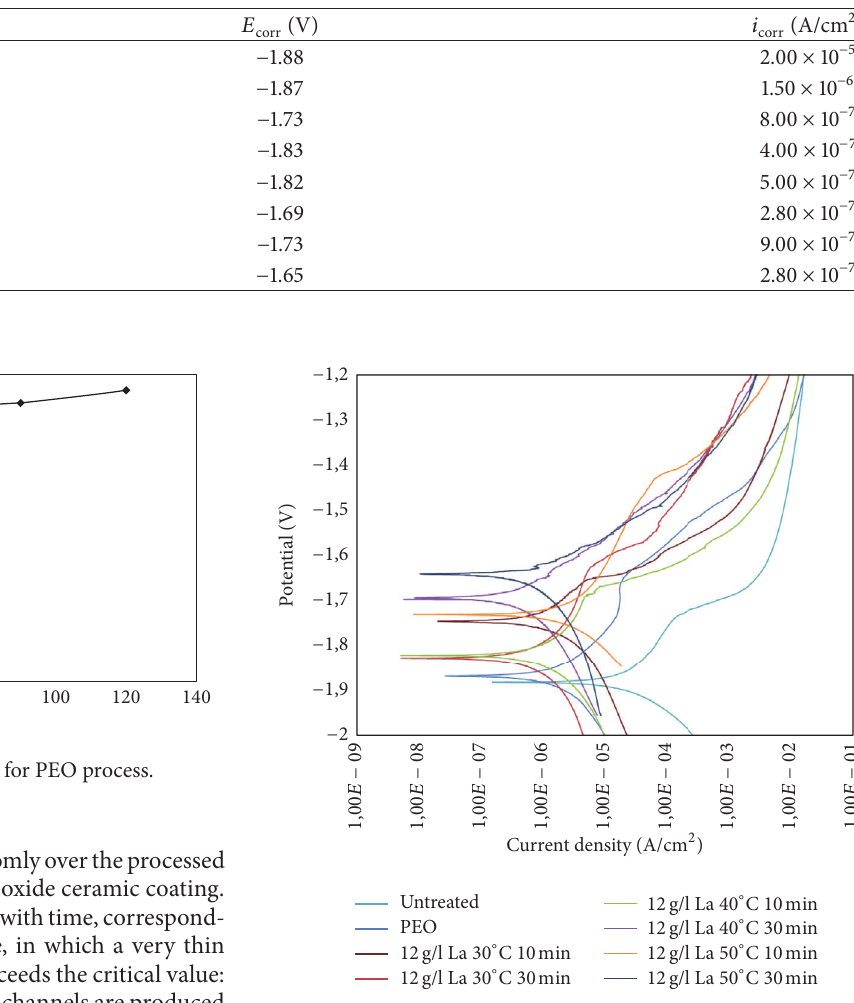
Figure 2: Potentiodynamic polarization plot of AZ91 magnesium alloy PEO coated at 0.5 A/cm 2 and sealed with 12g/l of La(NO 3 ) 3 with different treatment times and